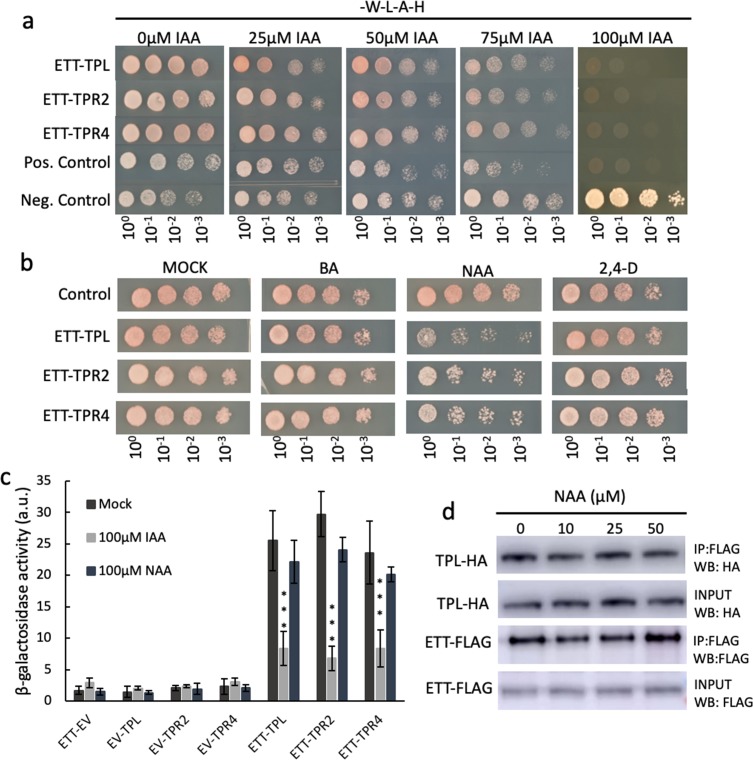
Interaction between ETT and TPL, TPR2 and TPR4 is auxin-sensitive and specific to IAA.(a) In Y2H increasing concentrations of IAA lead to reduction of yeast growth abolishing the interaction between ETT and its partners. The interactions are, therefore, auxin-sensitive. (b) Y2H to test specificity of auxin-sensitivity using benzoic acid (BA), NAA, and 2,4D in a yeast growth assay. The data suggest that the auxin-sensitivity observed in (a) is IAA-specific. (c) Y2H-based ONPG assay quantifying β-galactosidase activity as a measure of interaction strength.( d) Co-IP experiments show that the interaction between ETT and TPL cannot be disrupted by the synthetic auxin, NAA. The data support that the ETT TPL/TPR interactions are sensitive to IAA but not to NAA. ***p<0.0001; Shown are mean ± standard deviation of three biological replicates. See Figure 3—source data 1 for statistical analyses.